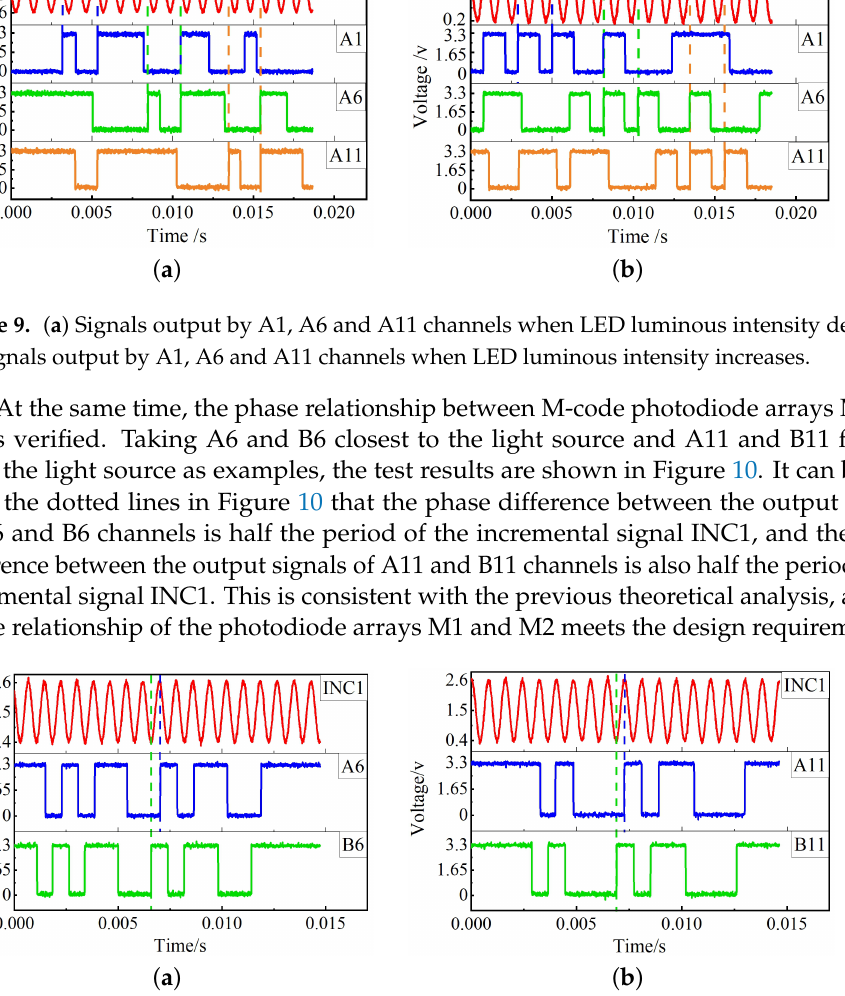
Figure 10. ( a ) Phase relationship of A6 and B6 output signals. ( b ) Phase relationship of A11 and B11 output